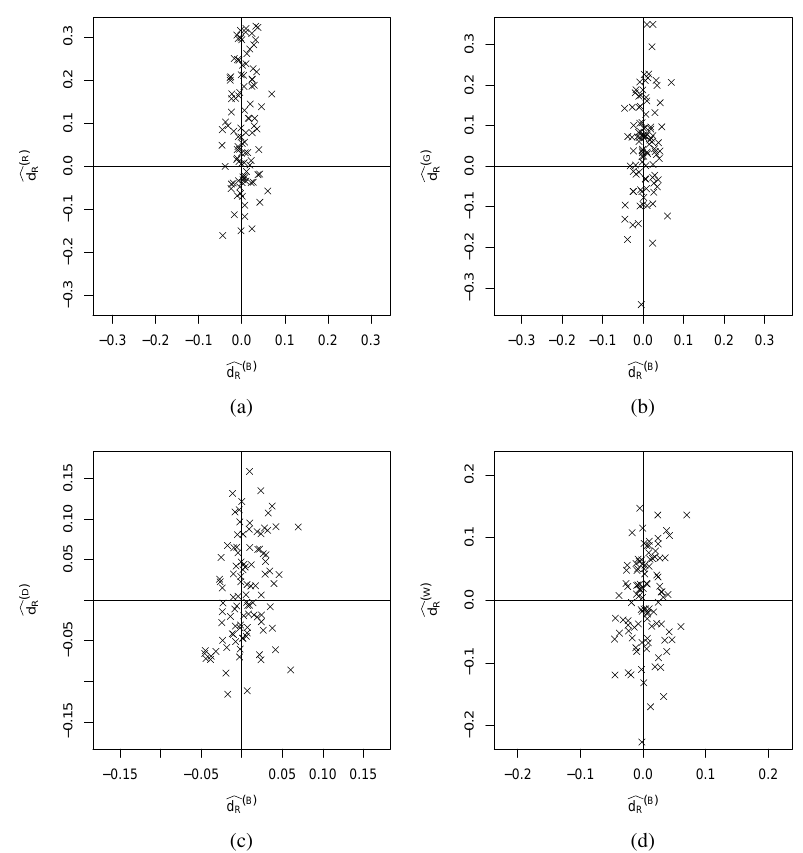
Figure 5. Comparison of Bayesian estimator with common classical estimators: (a) R/S , (b) GPH, (c) DFA, and (d) wavelet.